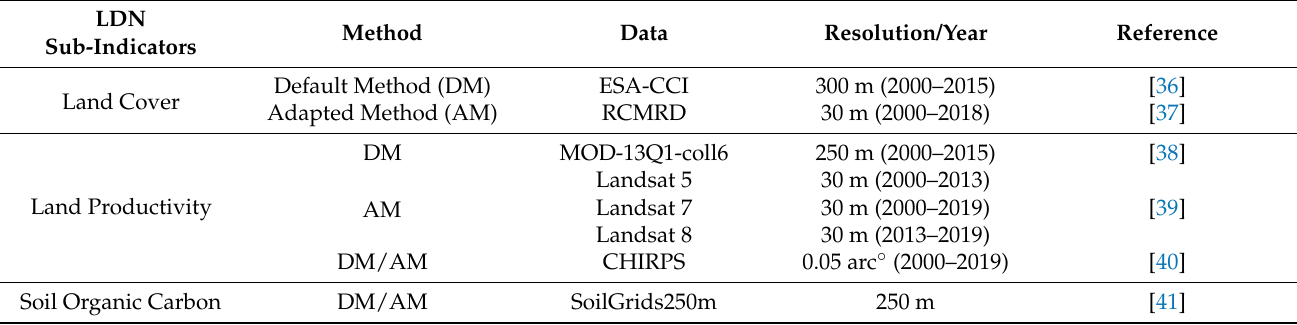
Table 1. The datasets used for land degradation neutrality (LDN) reporting. For the land cover, the European Space Agency Climate Change Initiative (ESA-CCI) and the Regional Center for Mapping of Resources for Development (RCMDR) were used. Land productivity is based on the Moderate Resolution Imaging Spectroradiometer (MODIS) and Landsat. The precipitation is based on the Climate Hazards Group InfraRed Precipitation with Station data (CHIRPS). Lastly, the soil organic carbon content is derived from